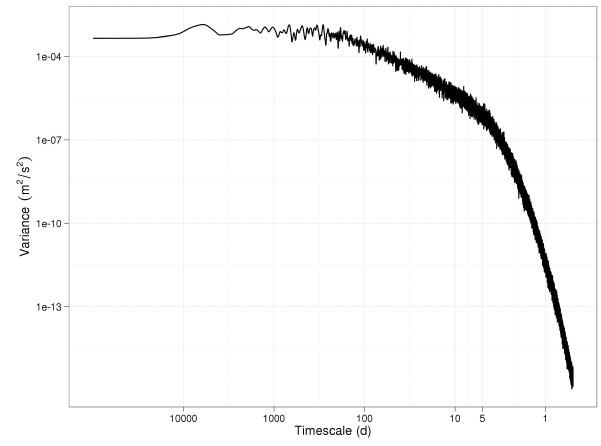
Fig. 7. 1 /T s versus 1 /T n when all variables are connected. The text labels show the associated T n .